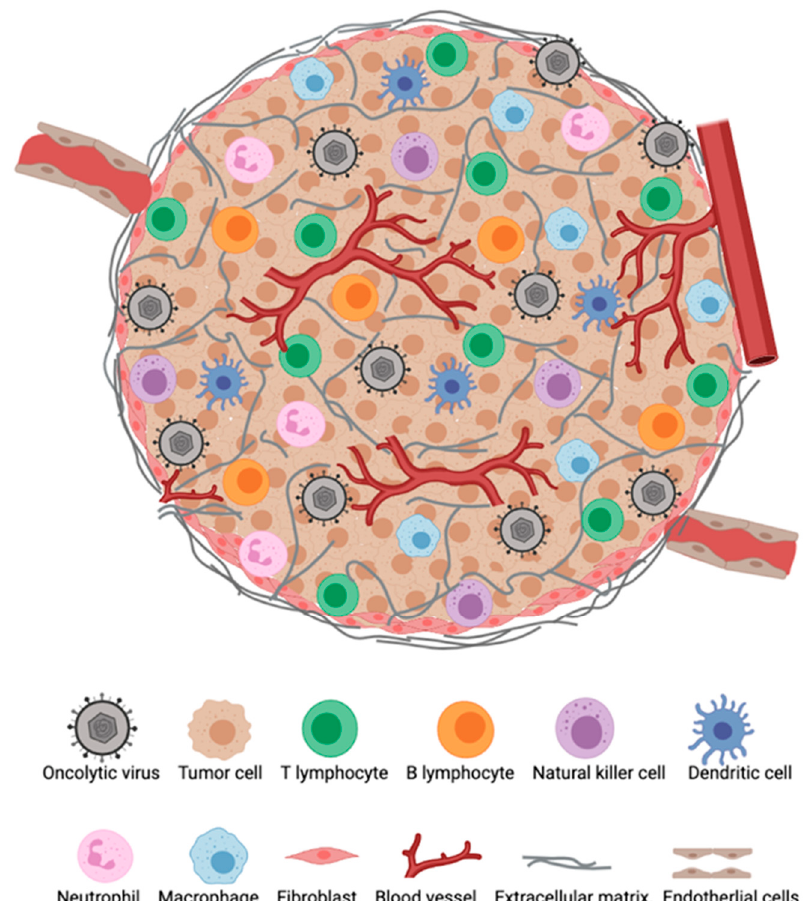
Figure 1. The tumor microenvironment (TME). Major cellular constituents of the TME during oncolytic virotherapy